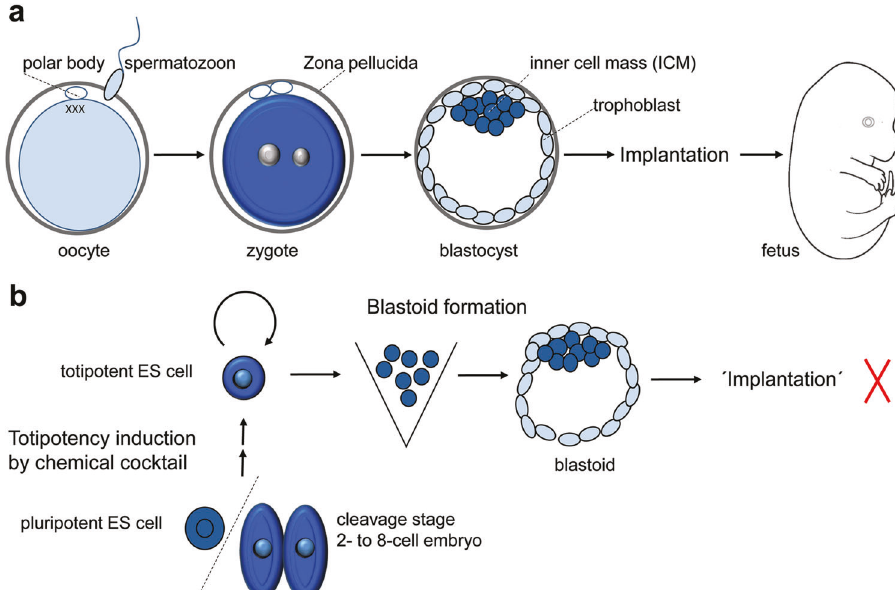
Fig. 1 In vivo and in vitro totipotency. a Totipotency during ontogenesis: fertilization sparks cellular reprogramming resulting in a totipotent zygote, which can develop into a fetus after implantation. In vivo totipotency is a rapidly passing condition present only in zygote and blastomeres of the fi rst cleavage division. b In vitro totipotency: Totipotency can be induced and captured in pluripotent ES cells or early cleavage stages by cocktails of de fi ned chemical compounds. By a 3D culture environment, the totipotent stem cells can be triggered to self- organize into a blastocyst-like structure — a blastoid — which is able to initiate implantation. However, no further structured development has been achieved to date indicating that something is still